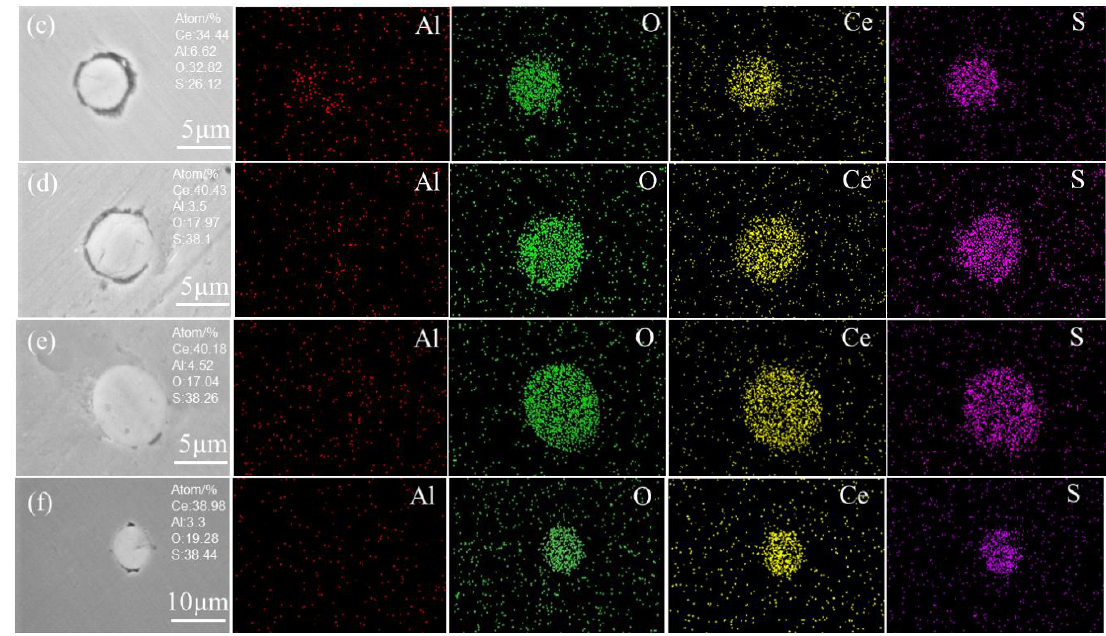
Figure 2. SEM / EDS image of typical inclusions in the sample S1–S4. ( a , b ) sample S2, ( c , d ) sample S3, ( e , f ) sample S4.